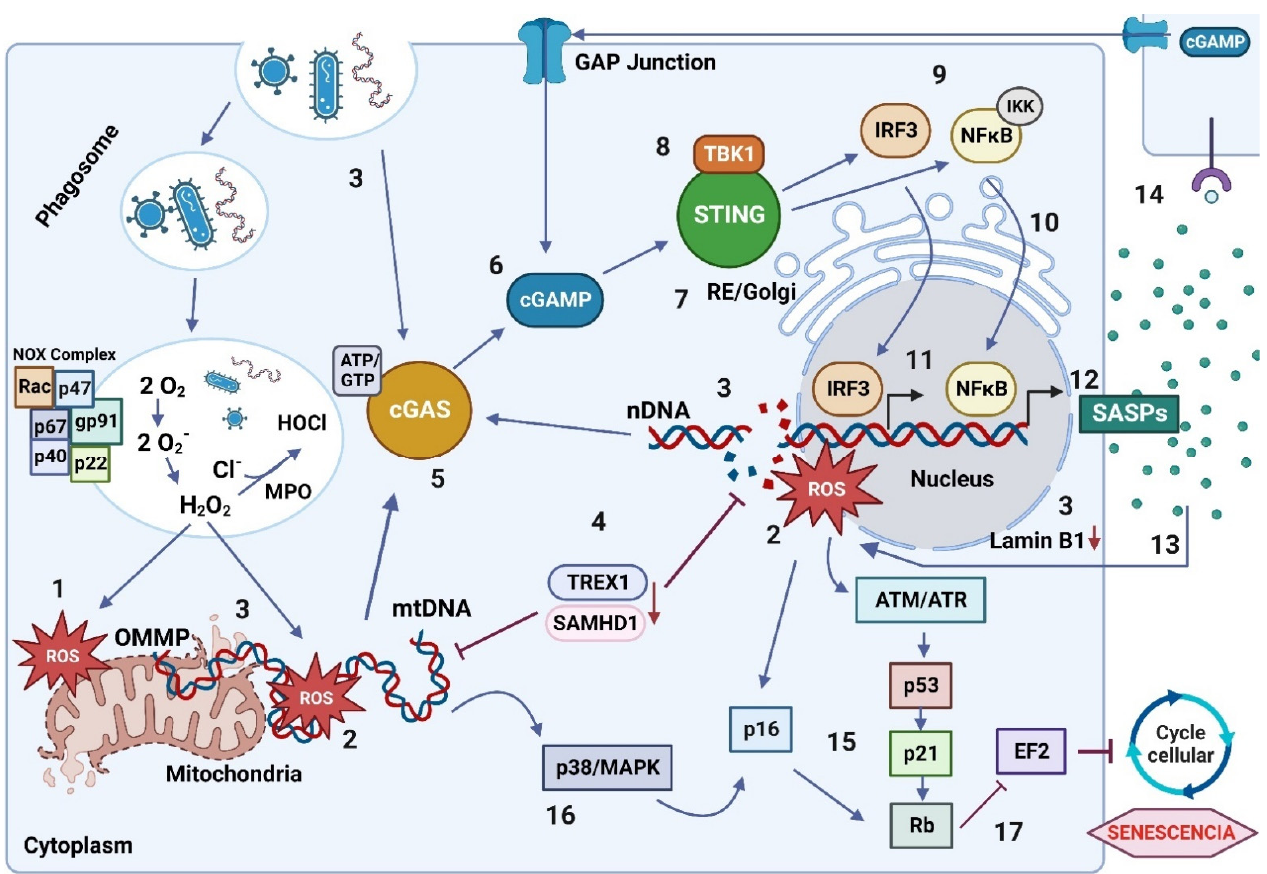
Figure 8. Proposed Relationship Between the cGAS/STING Signaling Pathway and ROS During Inflammaging in the Senescent Macrophage. (1) Increased ROS production is generated from sources such as mitochondria and oxidative burst (2) ROS induce damage to mitochondrial and nuclear DNA (3) Damaged mtDNA is located in the cell cytoplasm, moving from the interior of mitochondria due to increased Outer Mitochondrial Membrane Permeabilization (OMMP) and nuclear DNA moves from the nucleus to the cytoplasm due to decreased structural protein Lamin B1. In addition, the accumulation of DNA in the cytoplasm is generated by alterations in the function of the degrading enzymes DNase II and TREX1 (4). The sensor protein cGAS recognizes nuclear and mitochondrial DNA in the cytoplasm (5). After binding with DNA, cGAS is activated and produces 2 ′ 3 ′ cGAMP from GTP and ATP. cGAMP has the ability to exit the cell and enter another neighboring cell through GAP junctions (6) cGAMP binds to STING in the ER and STING moves to the Golgi (7) STING forms a complex with TBK1 which phosphorylates it (8) TBK1 generates the parallel phosphorylation of IRF3 and IKK (9) IKK phosphorylates I κ B and NF κ B remains free (10) IRF3 and NF κ B translocate to the nucleus (11) IRF3 and NF κ B initiate transcription of genes such as IFN I and IL-6, IL-8 and TNF α , respectively (not shown in the figure), which together form part of the SASPs (12) The SASPs induce an increase in ROS, which increase oxidative damage, generating a positive feedback loop on the activation of the cGAS/STING pathway (13) SASPs released in the cell are able to reach neighboring cells to induce senescence, inflammation and ROS in the tissue (14) DNA damage induces DDR (as mentioned in the text), with activation of p53-21 and p16 to induce a Rb (15) ROS induce MKK3/MKK6 signaling pathway (not shown) for activation of p38 MAPK (16) p38 MAPK activates p53 and p16 for the induction of Rb (17) Rb generates the inhibition of the EF2 factor, which produces irreversible cell cycle arrest and activation of senescence.